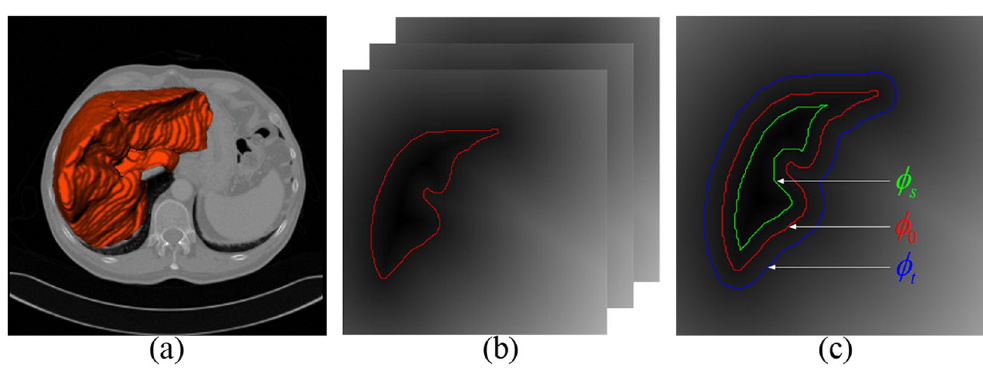
Figure 3. ( a ) The initialized liver shape. ( b ) The unsigned distance field according to the initial segmentation. ( c ) The selection of source and sink seeds on the unsigned distance